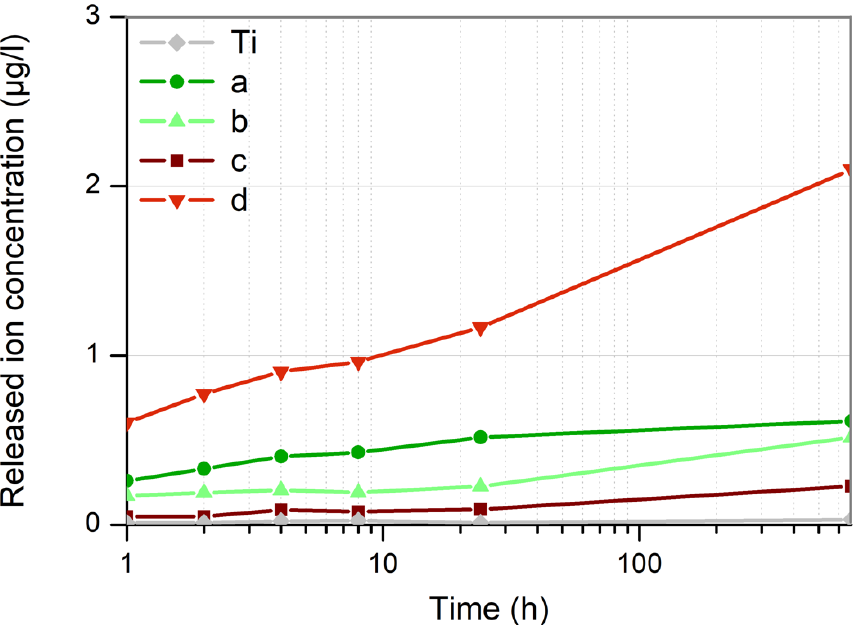
Figure 9. Palladium ions release kinetics from cp Titanium discs with immobilized Pd nanoparticles on their surface, obtained by laser ablation with ( a ) 532 nm of wavelength in water, ( b ) 532 nm in methanol, ( c ) 1064 nm in water and ( d ) 1064 nm in methanol.